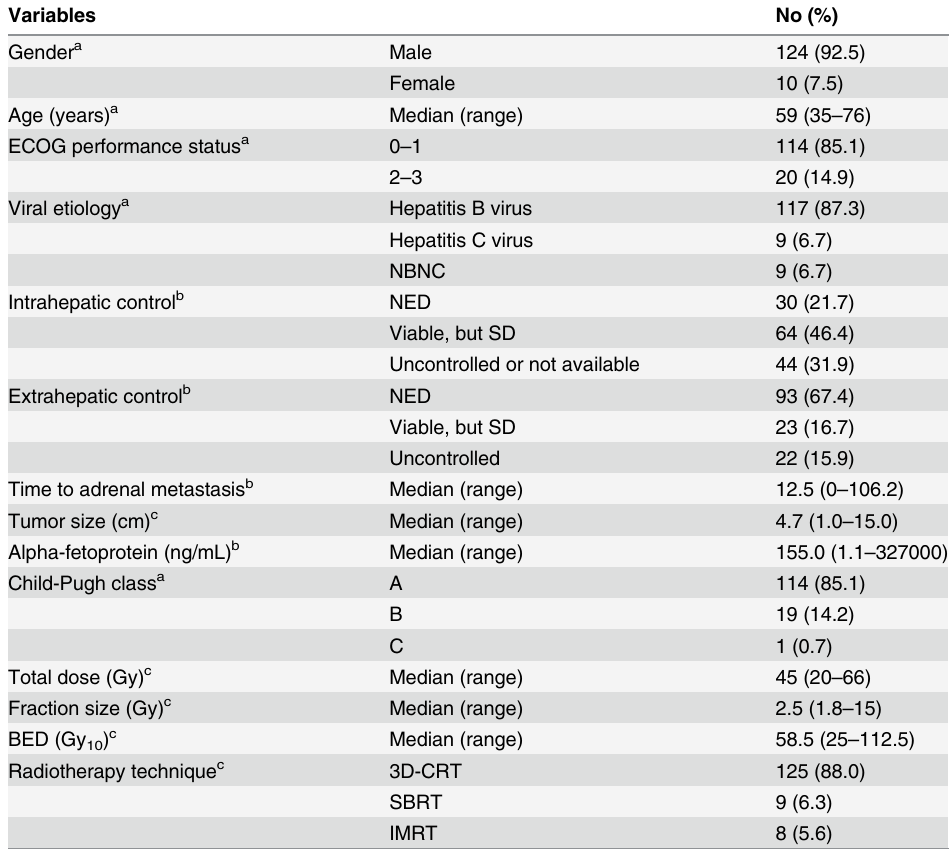
Table 1. Patient characteristics and summary of treatment.